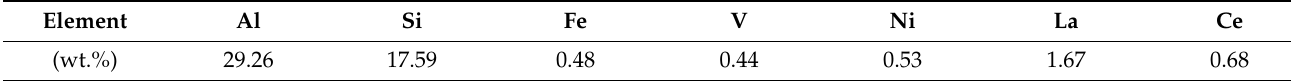
Table 1. Elemental analysis of the SFCC catalyst.